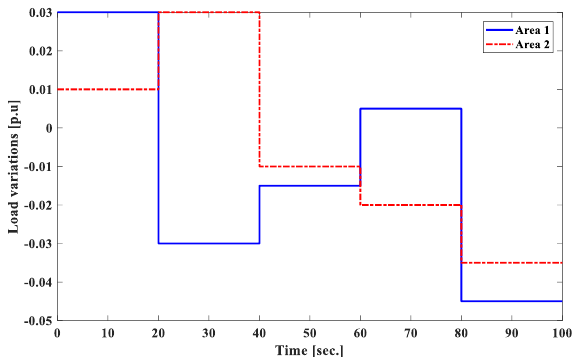
Figure 5. Variation load [p.u.] of areas 1 and 2 of the power system.